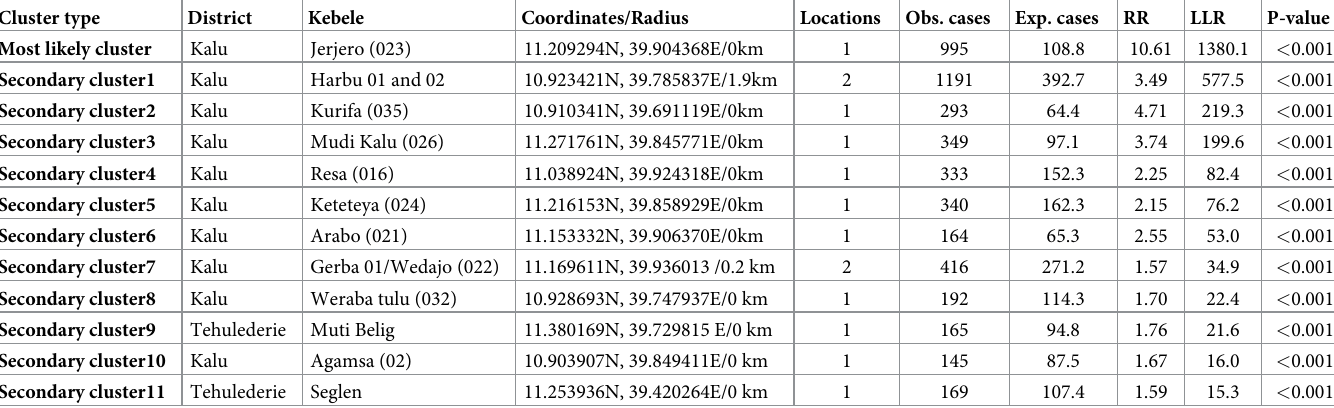
geted areas. However, the difference was not statistically significant and warrants further eval- uation of the effect of parasite clearance interventions on malaria incidence is essential to inform high-level decision-makers, program managers, and partners who are engaged in the malaria elimination program. The global spatial autocorrelation of malaria incidence showed malaria transmission was not randomly distributed across the study areas and periods. The purely spatial cluster and hotspot/cold spot analyses in this study identified a statistically significant most likely type of clusters, secondary clusters, and hotspot clusters of malaria cases in the community. This find- ing agreed with the existing literature at the global, regional, and local scales [19, 21, 29, 31, 39, 54–56]. Table 4. Most likely and secondary clusters of malaria cases in Kalu and Tehulederie districts between epi week 37/2013 and 38/2018. Cluster type District Kebele Coordinates/Radius Locations Obs. cases Exp. cases